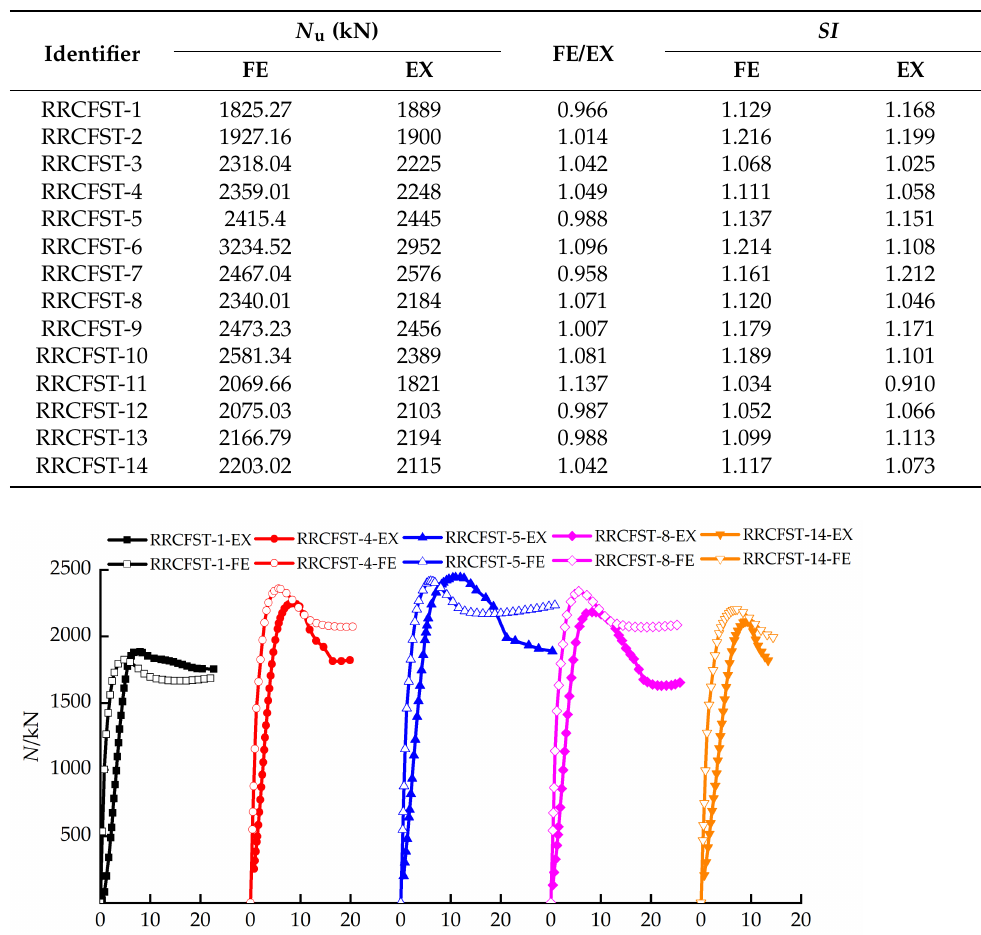
Table 3. Comparison of EX and FE bearing capacity.